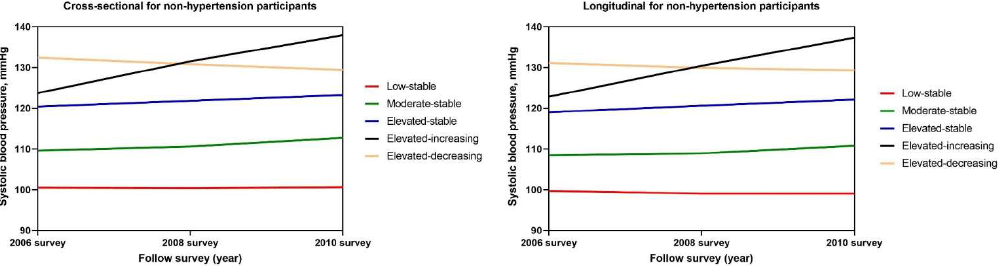
Figure 2. Systolic blood pressure (SBP) trajectory patterns for non-hypertensive participants from 2006 to 2010. SBP was classified into five groups according to the latent mixture modeling. The red line indicates the low-stable pattern, the green line indicates the moderate-stable pattern, the blue line indicates the elevated-stable pattern, the black line indicates the elevated-increasing pattern, and the yellow line indicates the elevated-decreasing pattern. The x-axis refers to the years of follow-up surveys of the participants. The y-axis refers to the SBPs of the